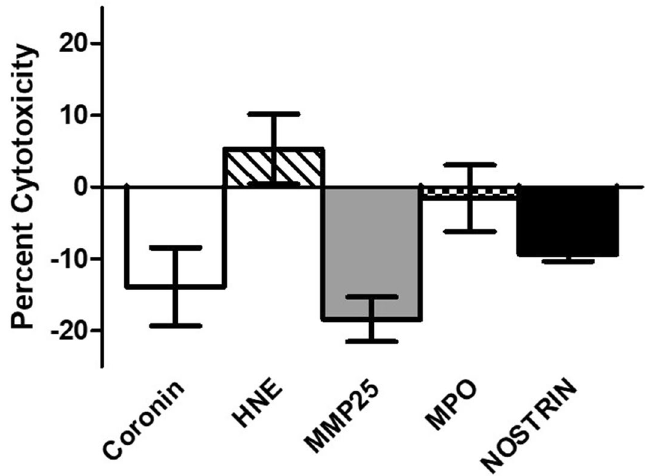
Figure 4. Cytotoxicity of Lysosomal Proteins. J774A.1 macrophages (5 × 10 5 cells/ml) were incubated in cell culture media alone or cell culture media with each antifungal protein at 100% concentration for 24 h at 37 °C, 5% CO 2, and percent cytotoxicity was calculated as per manufacturer’s instructions (pH 7.5). Data shown are means ± standard error of the means (SEM) of the cumulative results of three independent experiments (n = 3), with each condition performed in triplicate. All proteins tested had low cytotoxicity (<